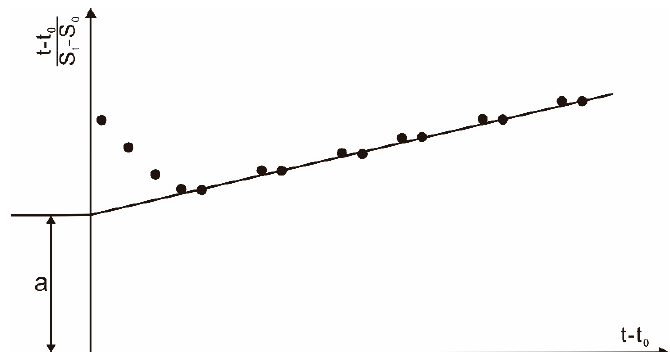
Figure 7. The diagram of the hyperbola method.